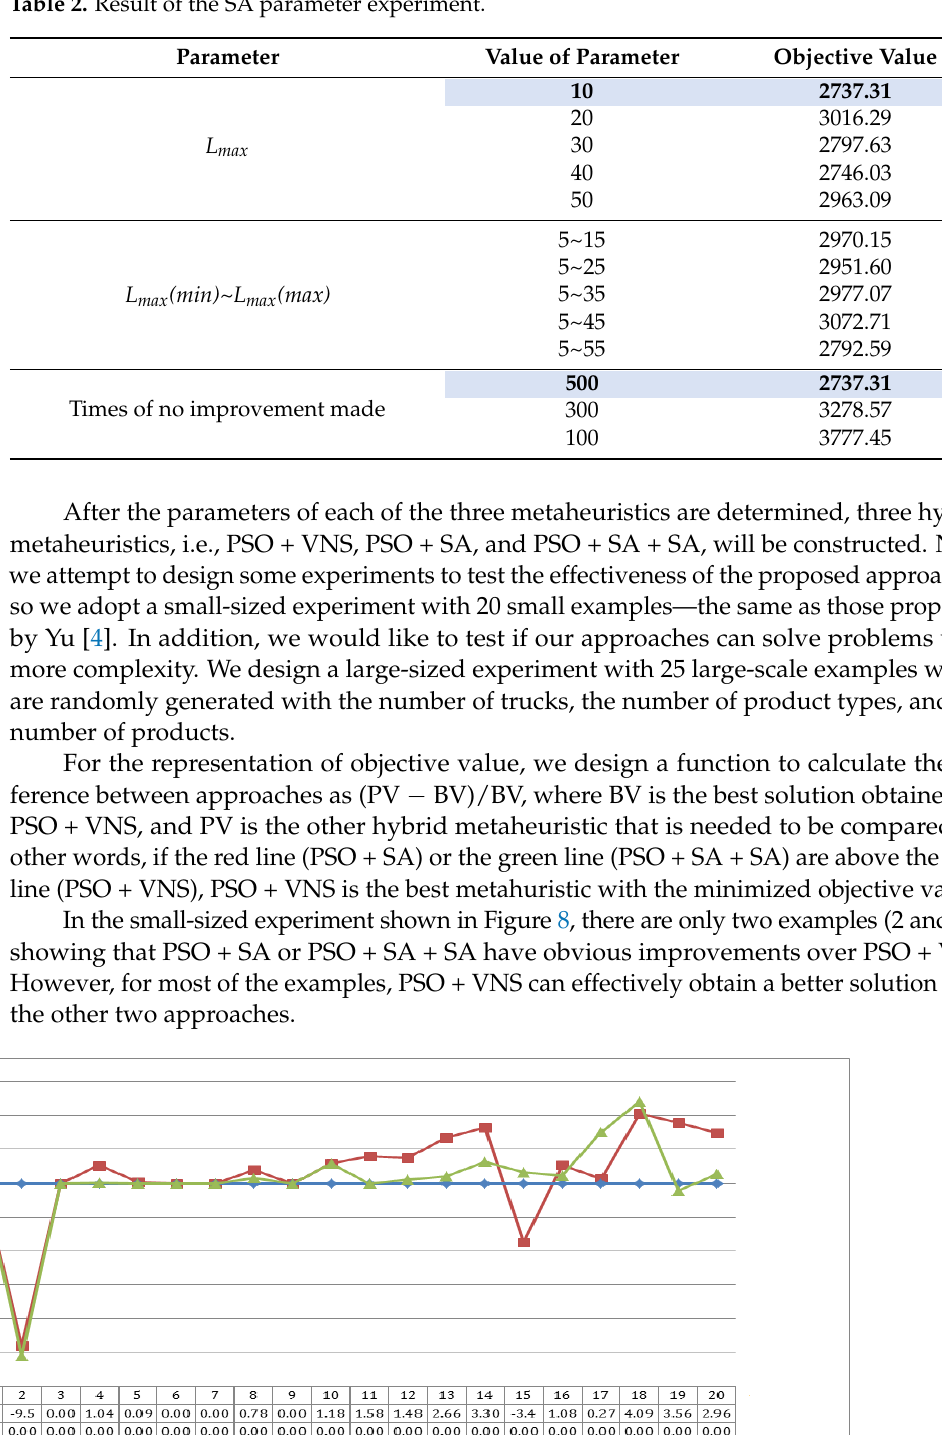
Table 2. Result of the SA parameter experiment.